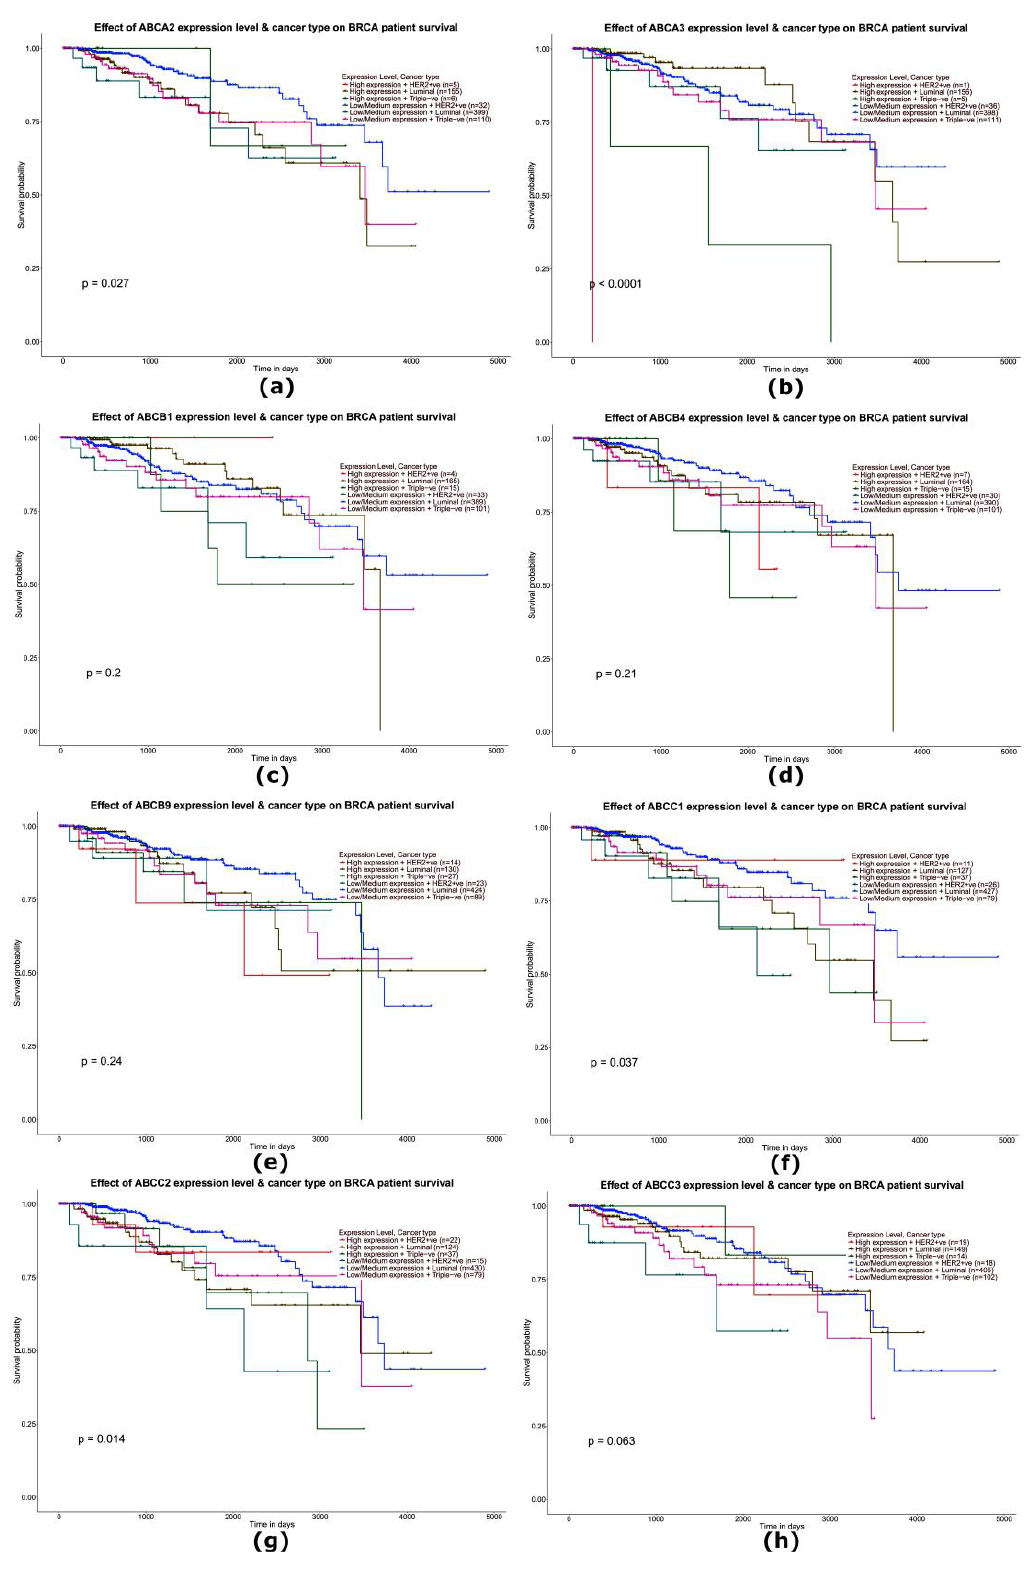
Figure 10. Survival curves (Kaplan–Meier plot) including ab assessment of the prognostic significance of the ABCA2 ( a ), ABCA3 ( b ), ABCB1 ( c ), ABCB4 ( d ), ABCB9 ( e ), ABCC1 ( f ), ABCC2 ( g ), and ABCC3 ( h ) genes in patients with breast cancer (different molecular subtypes). The data were generated using the online tool Ualcan.